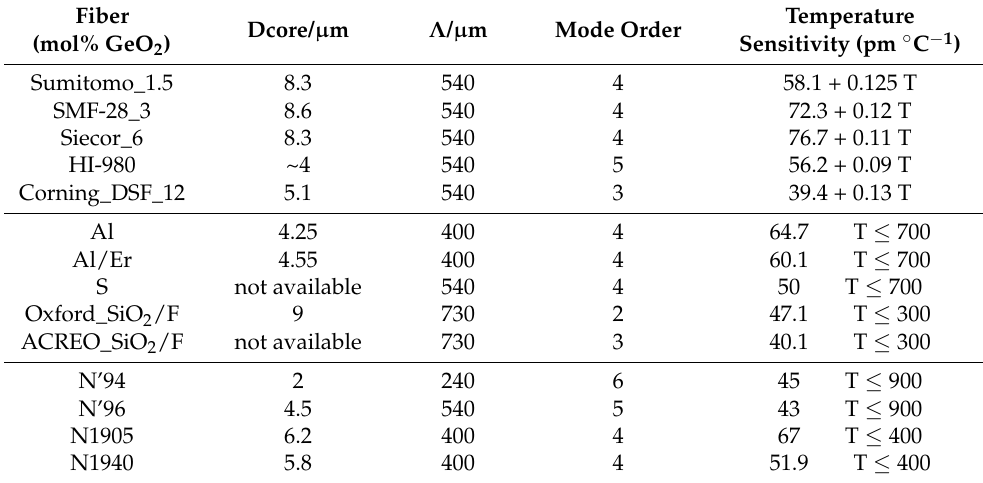
Table 1. Temperature sensitivity of gratings written in different fibers. Adapted from [86].